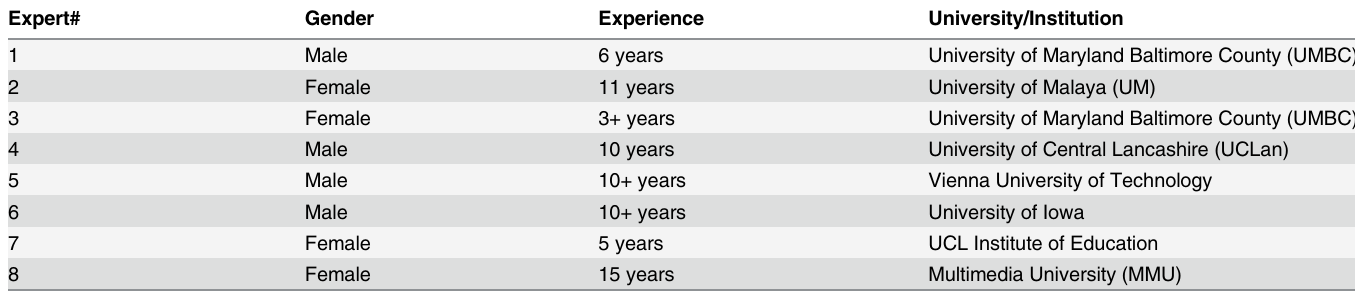
Table 3. Demographic profiles of